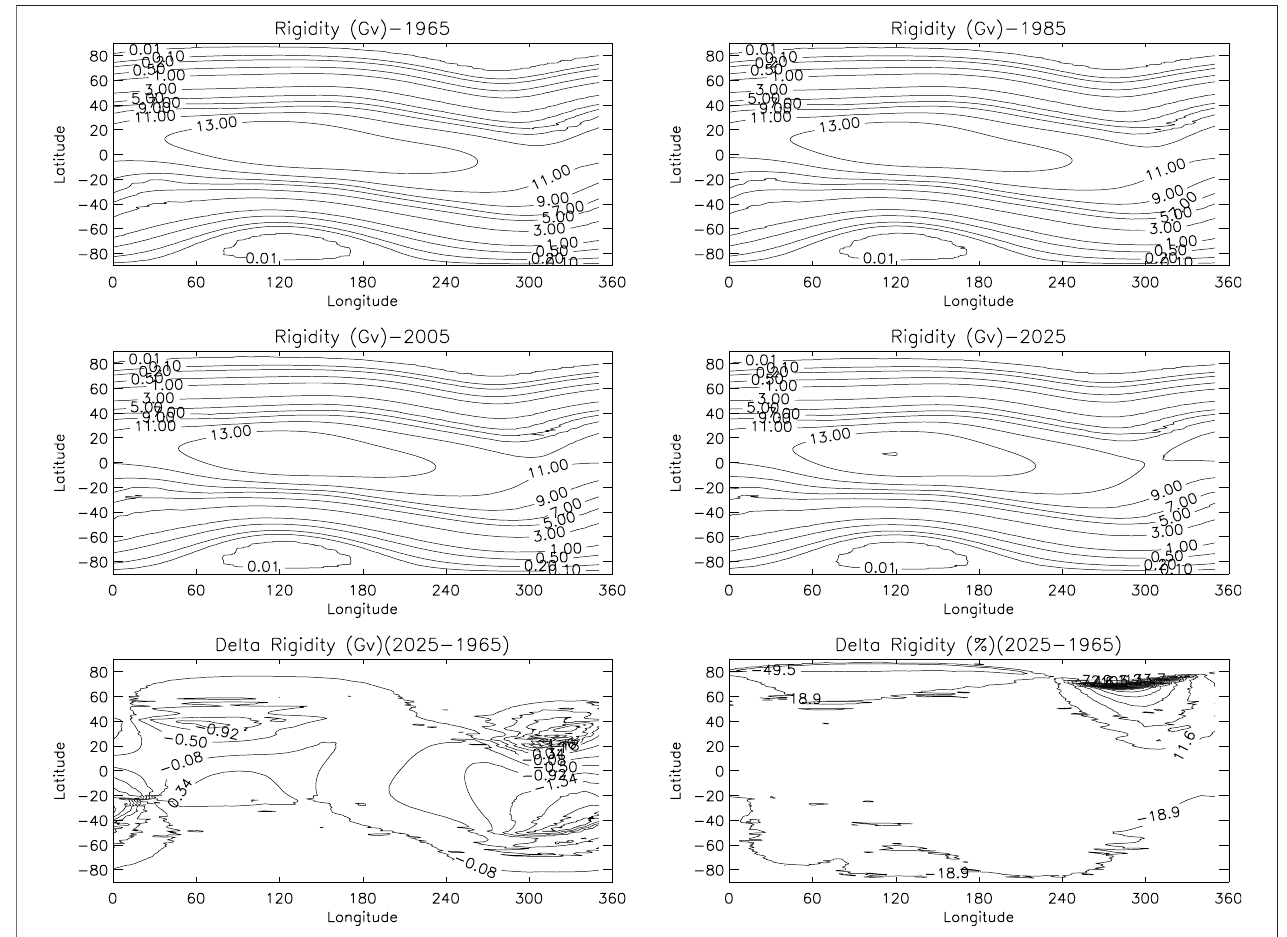
FIGURE 5 | Global contour of cutoff rigidities from 1965 to 2025 by every 20 years and their absolute and relative changes contour image.